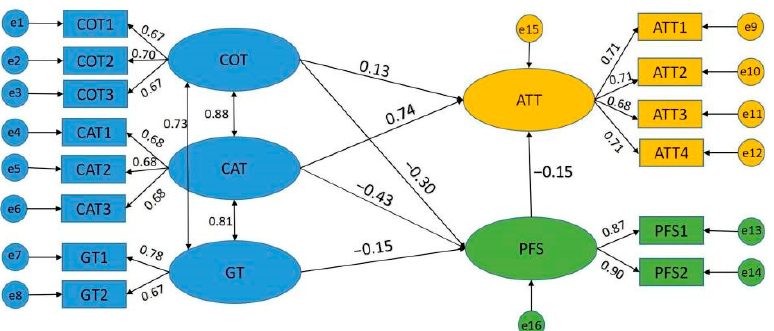
Figure 1. Structural Equation Model. COT: Competence trust; CAT: Care trust; GT: Generalized trust; PFS: Perception of food safety; ATT: The public’s attitude toward the high qualified rate of safety supervision sampling inspection of commonly consumed foods. Table 6. Direct Effect, Indirect effect, and Total effect (Public’s attitude toward the high qualified rate of safety supervision sampling inspection of commonly consumed foods).